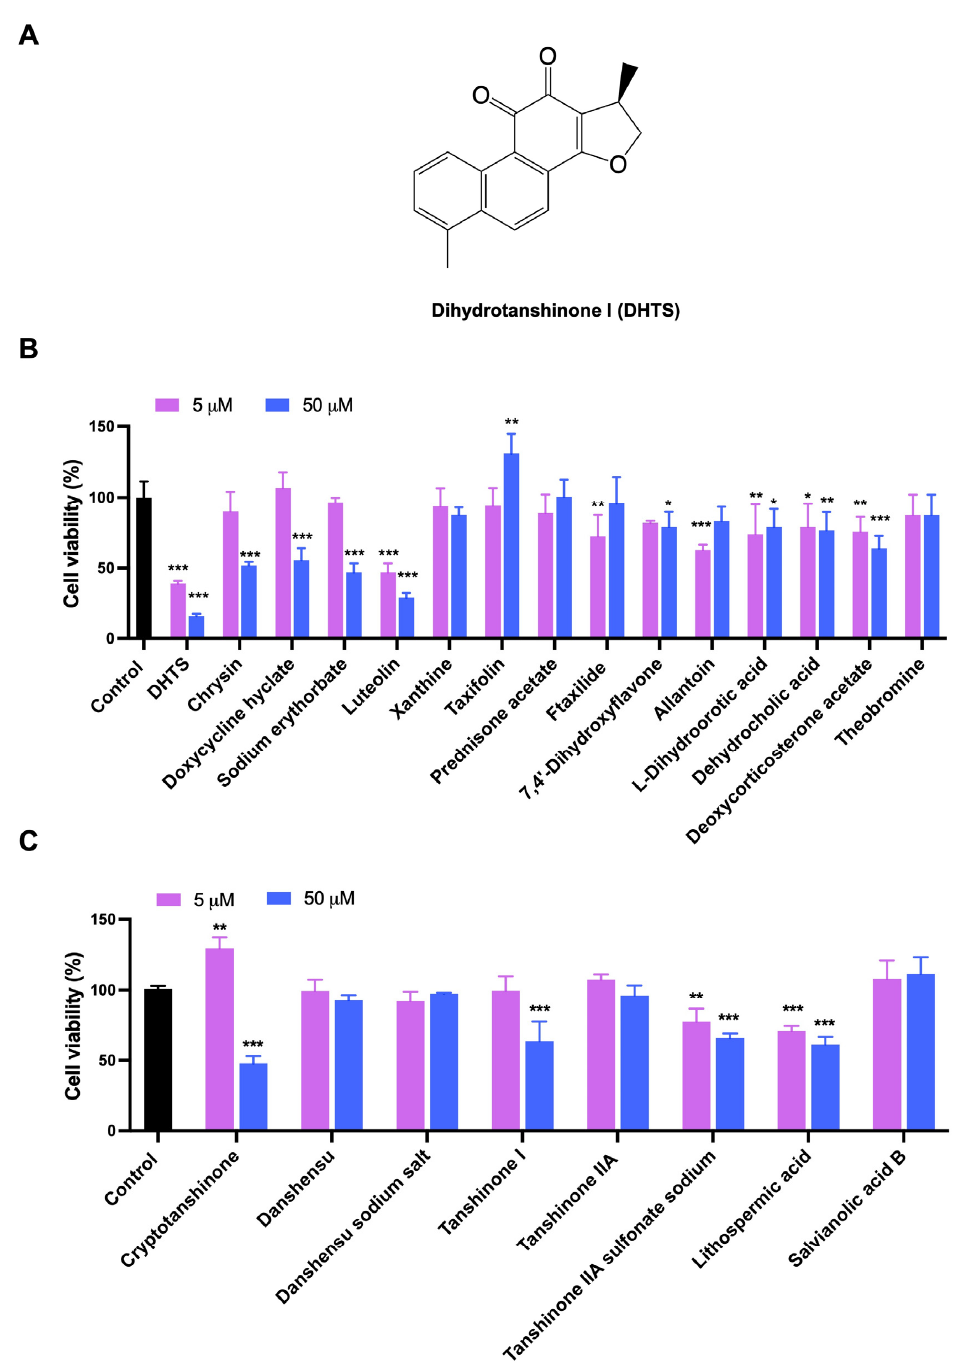
Figure 1. Evaluation for the growth inhibition of the test compounds in HCT116 cells. ( A ) The chemical structure of DHTS; ( B ) the inhibitory activities of 15 compounds from LBVS; ( C ) the inhibitory activities of 8 compounds from Salvia miltiorrhiza . HCT116 cells were treated with the test compounds at 5 and 50 μ M for 24 h by CCK-8 assay (compared to the control group, * p < 0.05, ** p < 0.01, *** p < 0.001).